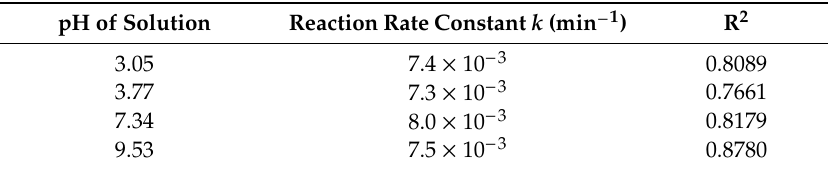
Table 4. The reaction rate of tetracycline degradation at di ff erent